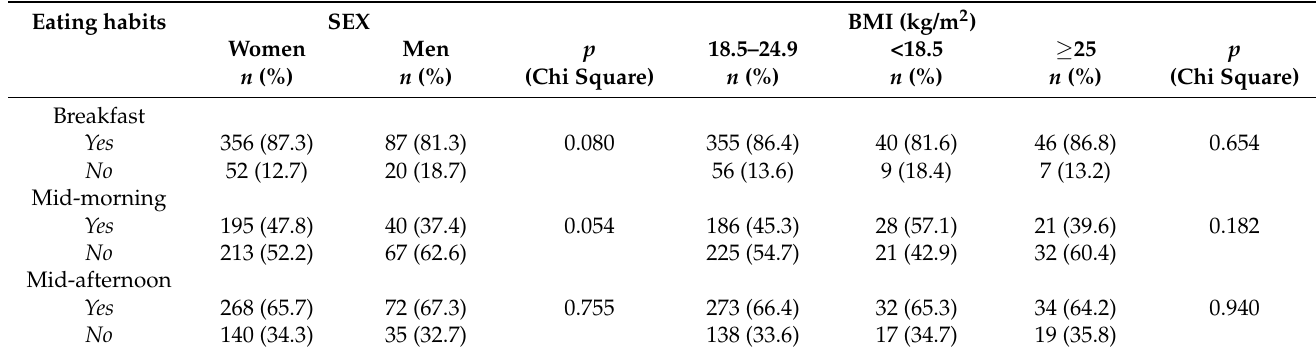
Table 2. Eating habits distributed by sex and